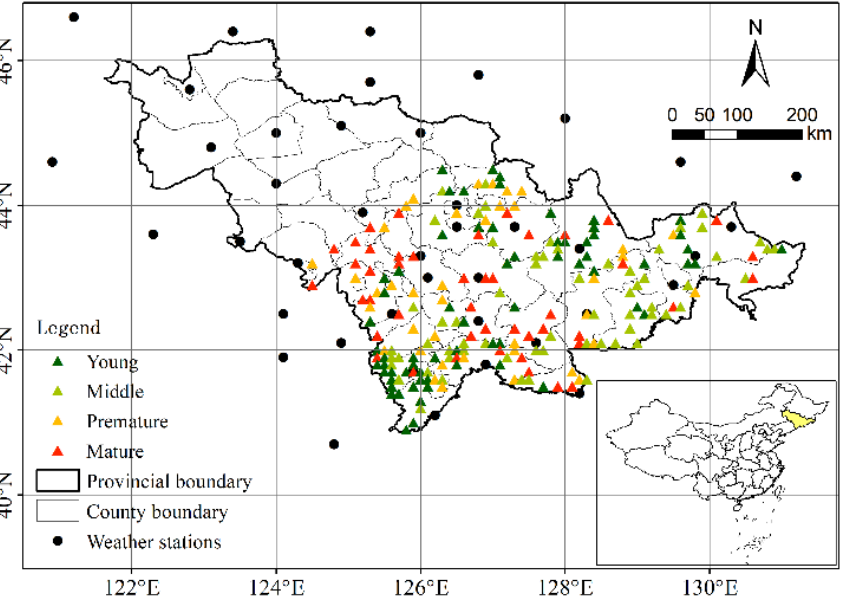
Figure 1. Distribution of the weather stations and Larix olgensis sampling plots in the study area.